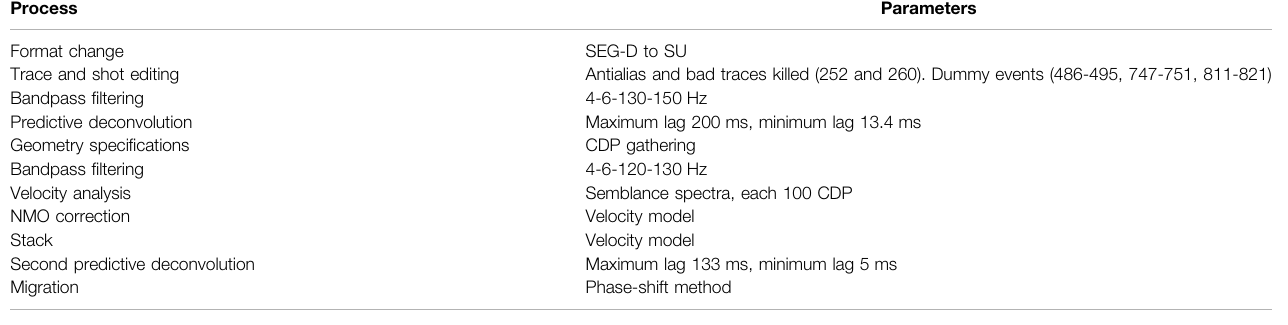
TABLE 2 | Processing fl ow applied to the TS08 multichannel seismic pro fi le using Seismic Unix. Process